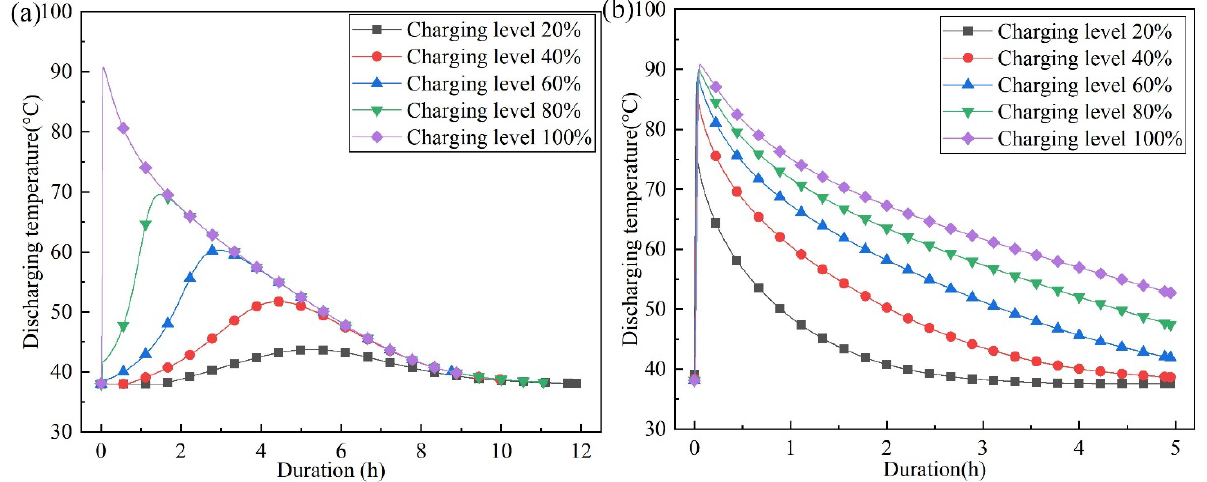
Figure 7. Temperature at air outlet varies with time when ( a ) the direction of the charging and discharging air flow is the same and ( b ) the direction of the charging and discharging air flow is